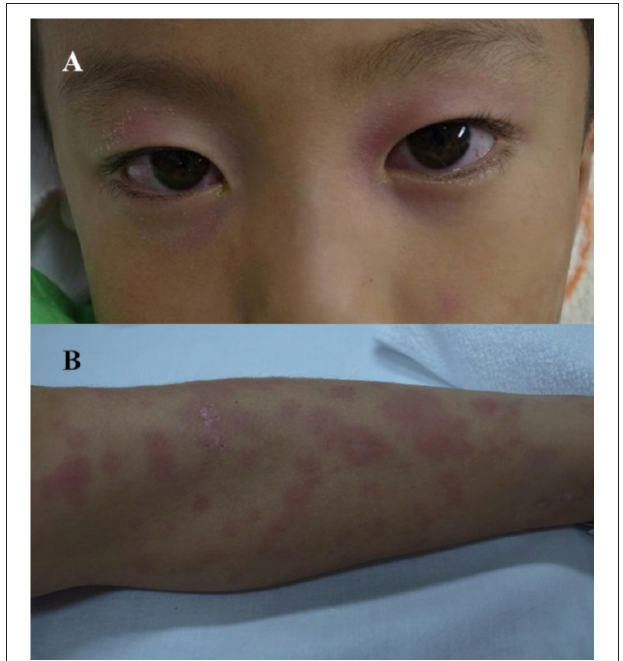
FIGURE 1 | Bulbar injection (A) , and macular erythema on the extremities (B) .